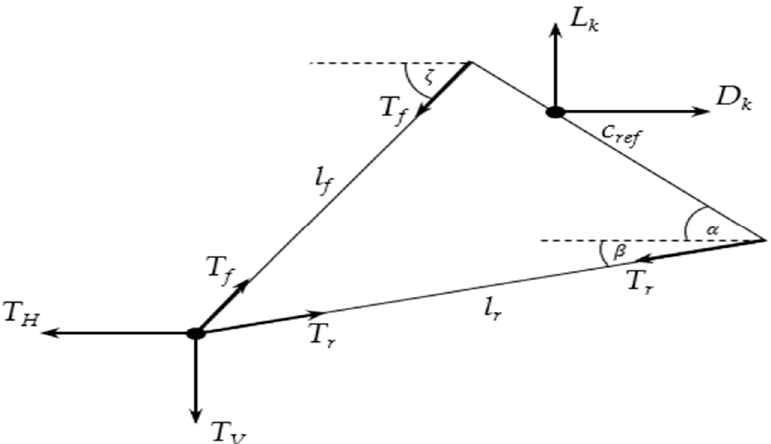
Figure 2. A free body diagram of the bridle lines of the kite sail showing the geometry together with the external and internal forces acting in equilibrium conditions for a given angle of attack, α .